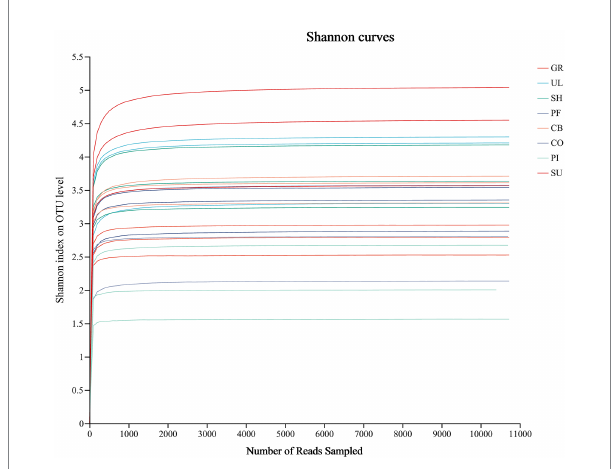
FIGURE 1 AMF community dilution curves for soil at different